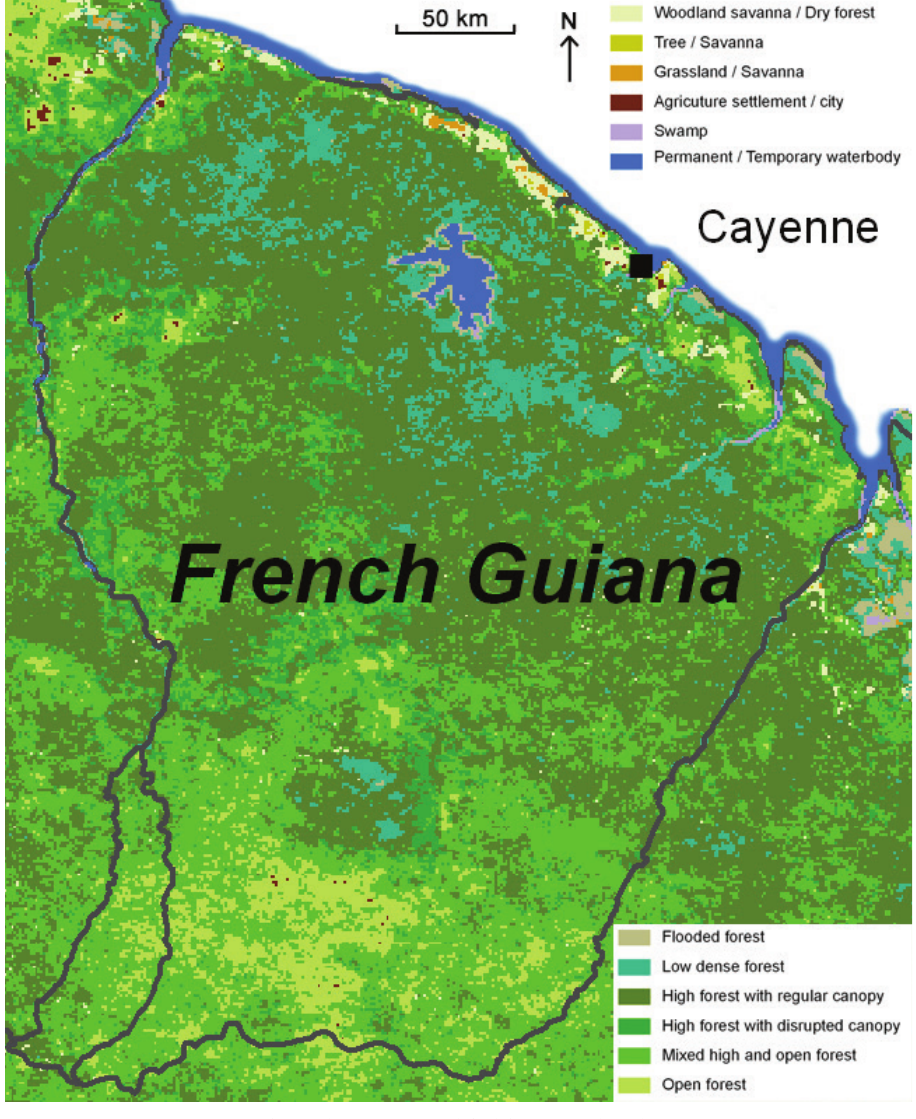
Figure 33. Vegetation map of French Guiana (modified from Gond et al. 2011).